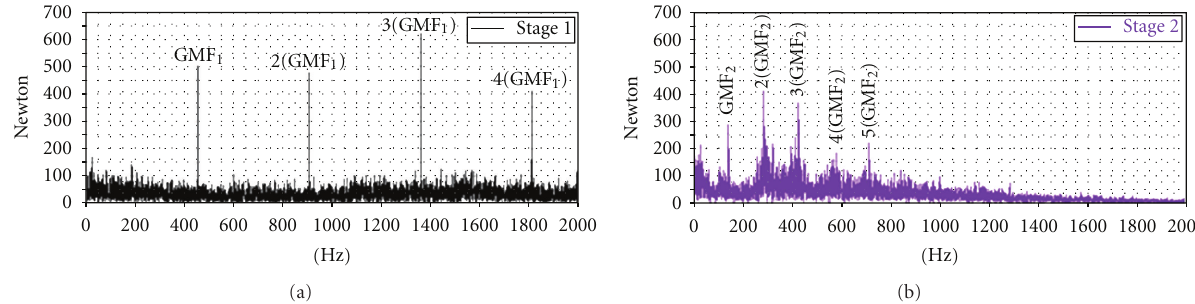
Figure 10: A comparison of frequency domain components of force magnitude on (a) Stage 1 and (b) Stage 2 with prescribed backlash and perfect